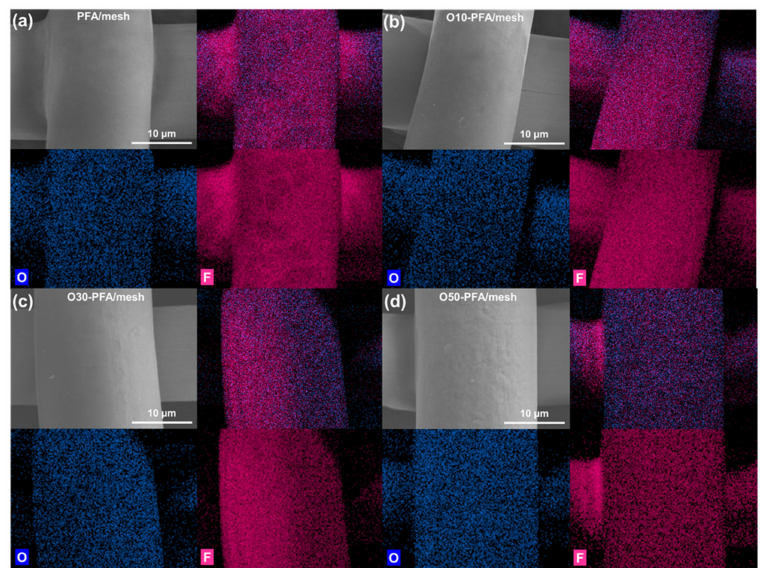
Figure 2. SEM–EDS images of ( a ) PFA-coated stainless-steel mesh, ( b ) O10-PFA/mesh, ( c ) O30- PFA/mesh and ( d ) O50-PFA/mesh.